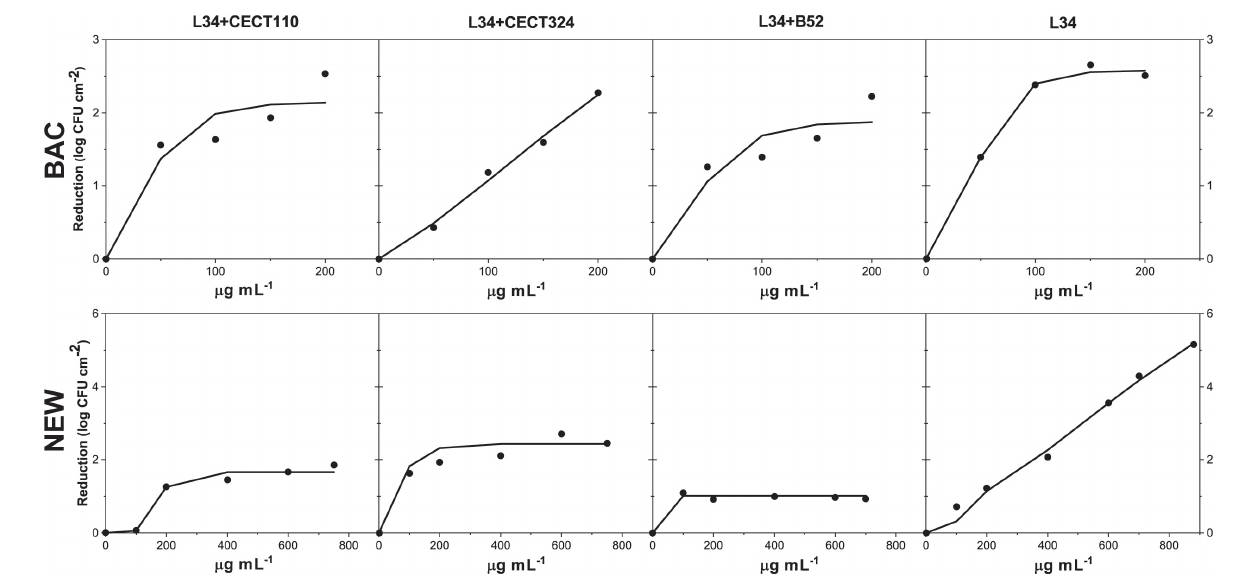
FIGURE 6 | Fit of the dose-response experimental data expressed in log CFU cm - 2 reduction, in 48 h biofilms of L34 alone and co-cultured with CECT 110, CECT 324, and B52 after the application a solution of either BAC or NEW according to Equation 1.